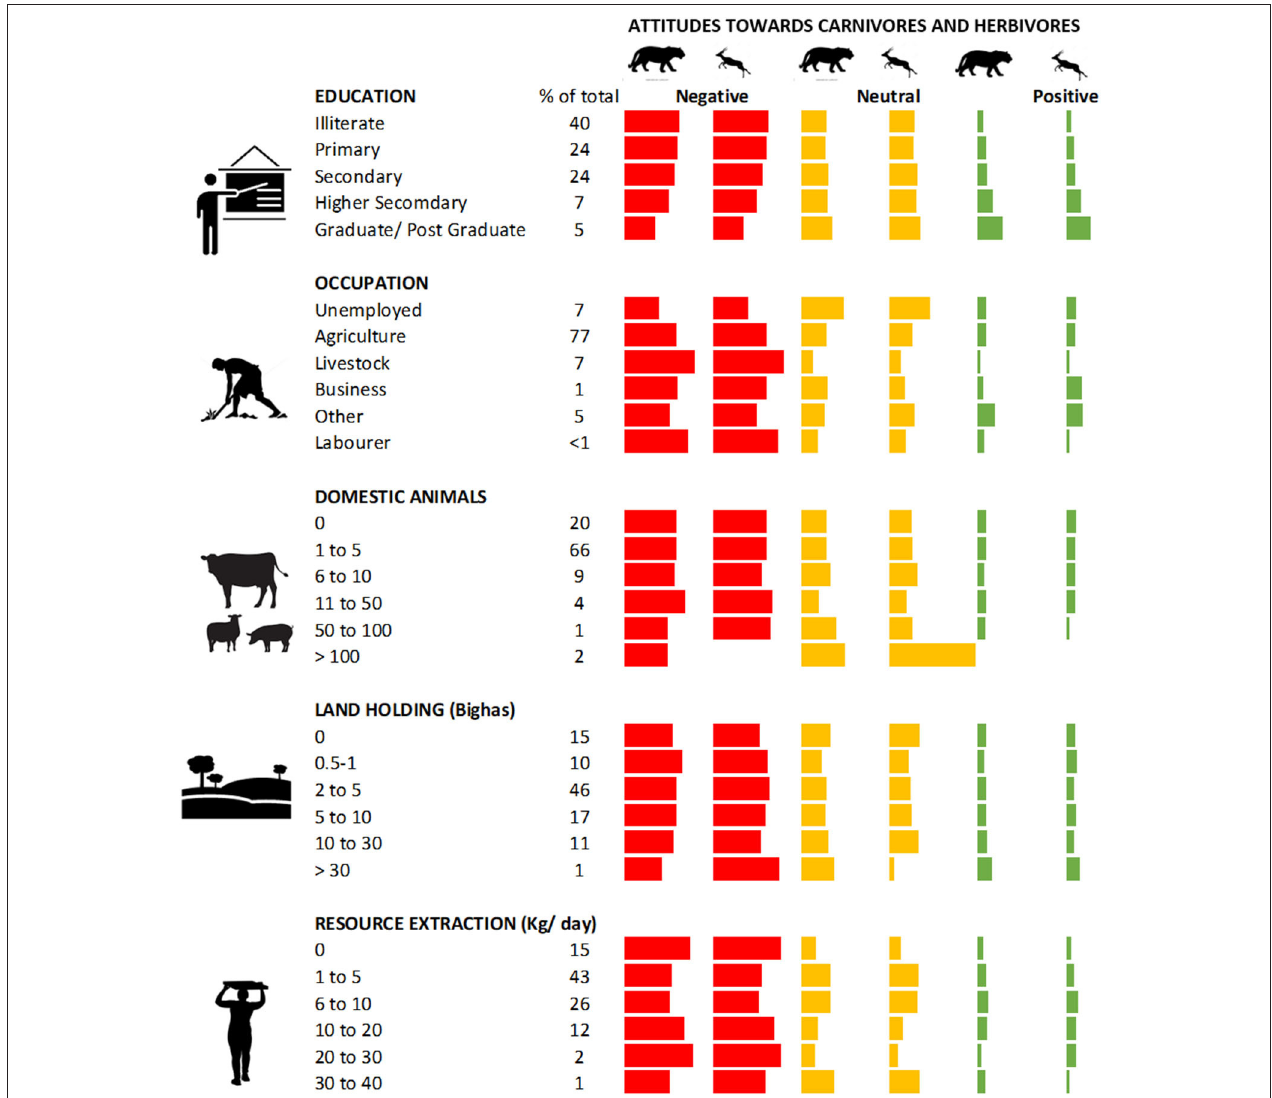
FIGURE 4 | Attribution of attitudes towards carnivores and herbivores on a three-point likert scale to respondents, summarised under various socio-economic and livelihood categories. Values are all proportions of the total respondents in each category. The percent of total respondents ( n = 1,962) in each category are reported as percent